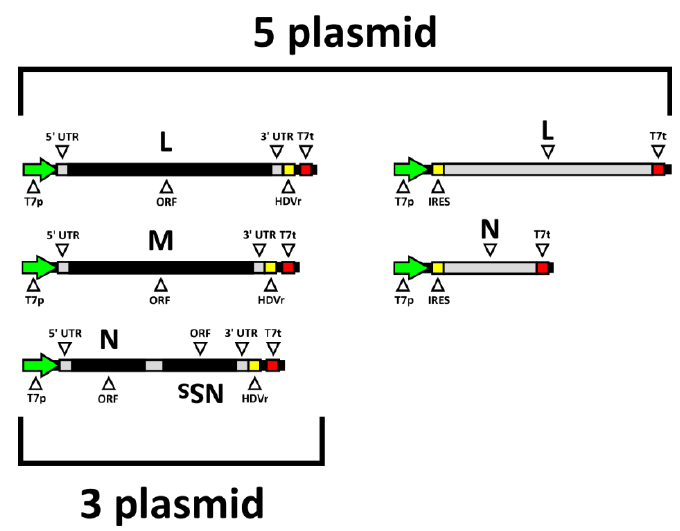
Figure 2. The TOSV rescue system. In the 5-plasmid system, the antigenome is expressed coupled to the hepatitis delta virus ribozyme (HDVr) for efficient RNA cleavage under control of the T7 RNA polymerase promoter (T7p) and T7 RNA polymerase terminator (T7t). These are supplemented with the L (RNA-dependent RNA polymerase, RdRp) and N (nucleocapsid) proteins. The 3-plasmid system omits these helper plasmids and relies solely on the antigenome-encoding plasmids.